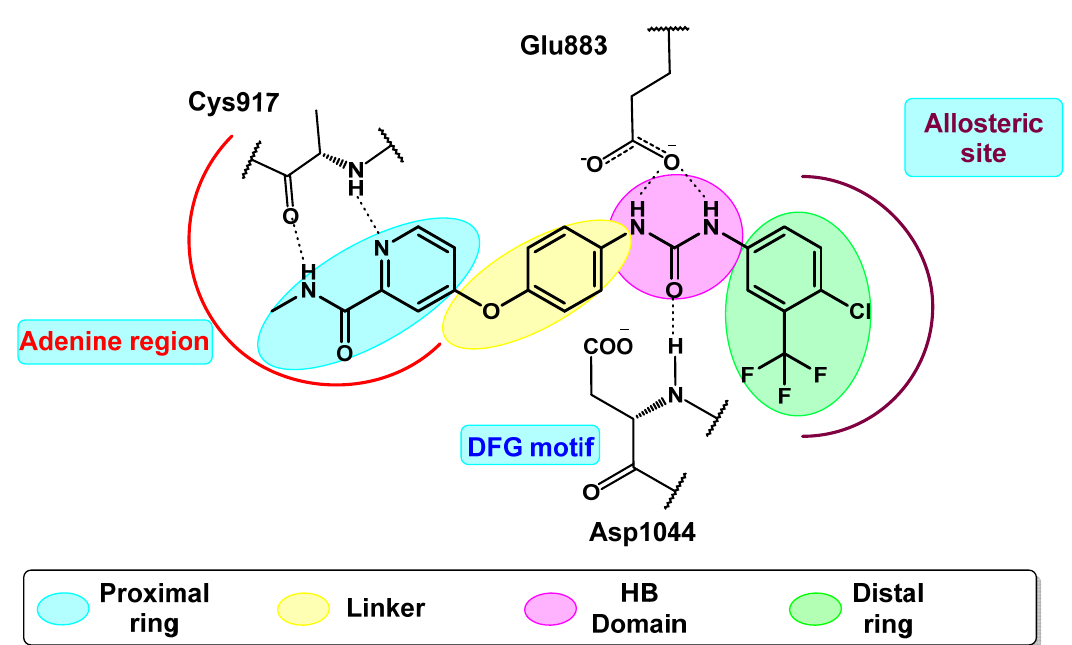
Figure 1. The essential pharmacophoric parts of sorafenib including a proximal ring (turquoise), a linker moiety (yellow), an HB domain (pink), and a distal ring (light green).